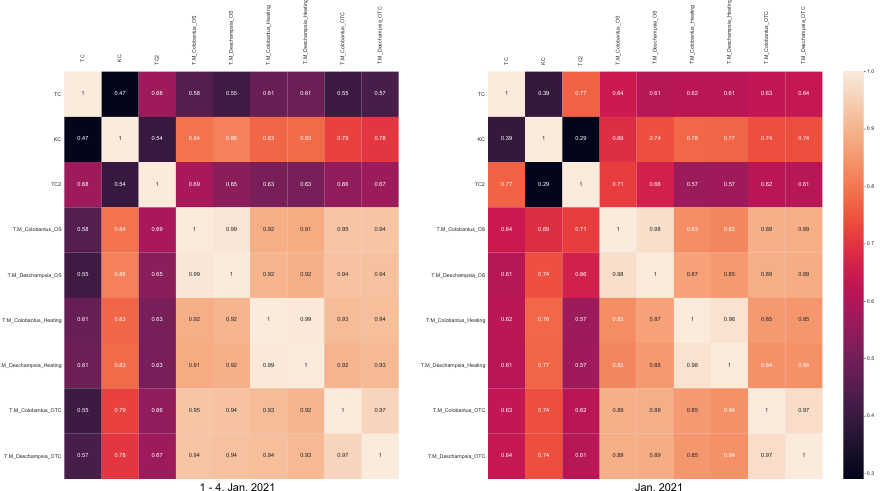
Figure 14. Correlation diagrams between data from weather station (TC—air temperature, TC2—soil temperature, KC—radiation) and leaves of the plants in different groups in a period of 1–4 January 2021 and whole month Jan